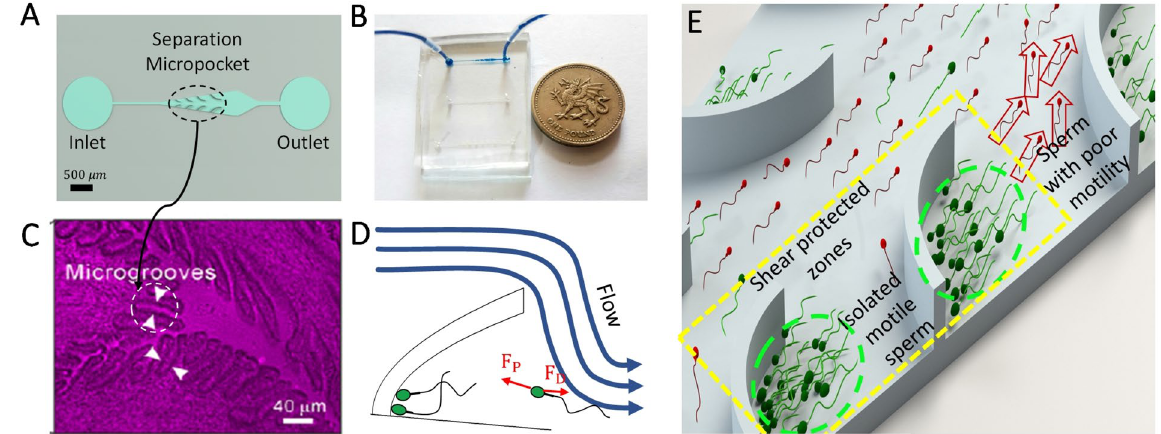
Figure 1. Microfluidic device featuring eight oval-shaped micro pockets for sperm separation. ( A ) Schematic view of the device geometry informed by oval-shaped microgrooves. ( B ) Photograph of the fabricated device. ( C ) the oval-shaped microgrooves within the female fallopian tubes as opposed to a part of the proposed microfluidic device 13 . ( D ) The rheotaxis-based separation process that reorients motile sperm against the flow to ( E ) isolate them into the selection micropockets. The sperm propulsive force, F P , should overcome the viscous induced drag, F D , to enable rheotaxis. Live and motile sperm (green) that exhibit rheotactic behavior were separated from the main flow, accumulating in the micropockets, while dead and non-motile sperm (red) were washed out of the device by the flow. Part C is reprinted with permission of the Proceedings of the National Academy of Sciences (PNAS), the official journal of the National Academy of Sciences (NAS) 13